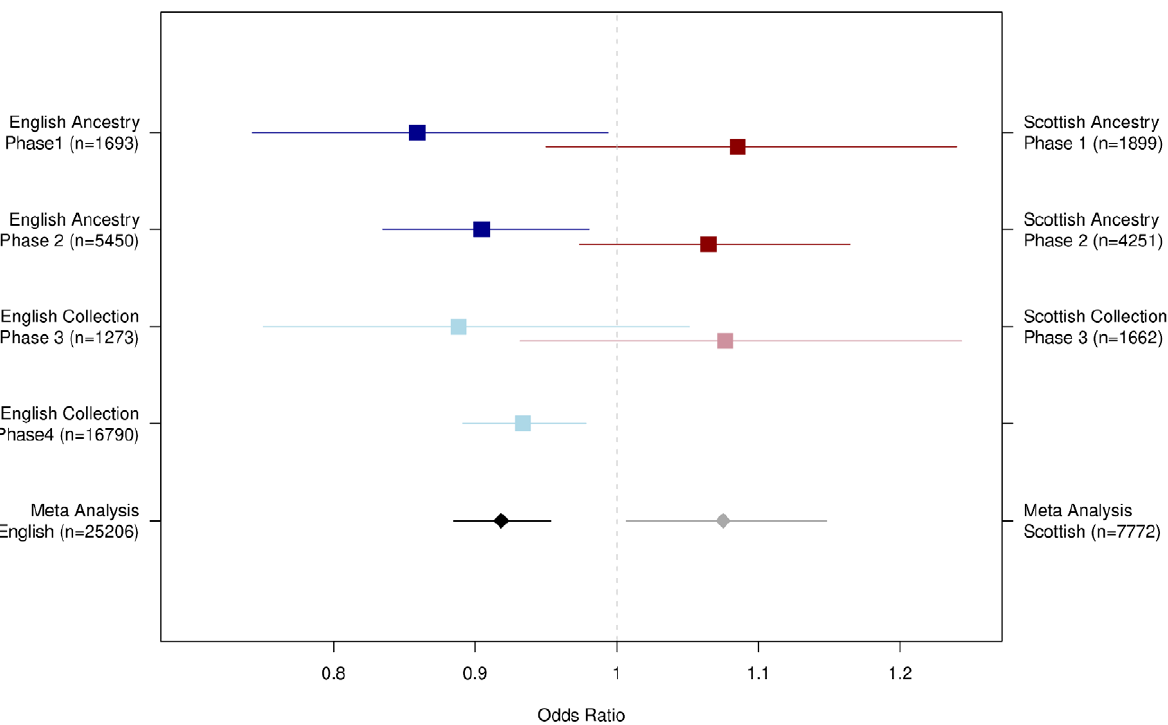
Figure 3. Summary of Association Evidence at rs10455. Forest plot of estimated effect sizes (with 95% confidence intervals). In Phases 1 and 2, the effect size is estimated from a logistic regression adjusted for gender within the English (blue) and Scottish (red) ancestry groups. In Phases 3 and 4 the effect size is estimated from a logistic regression adjusted for gender within the replication collection groups. The use of collections reduces power relative to what would be expected if ancestry groups were available. Finally we performed a meta-analysis combining all the individuals in Phase 1 and 2 Ancestry groups and Phase 3 and Phase 4 (English only) collection groups together with the additional WTCCC2 controls (coloured black and grey). The Odds Ratios are estimated from a logistic regression adjusted for gender.